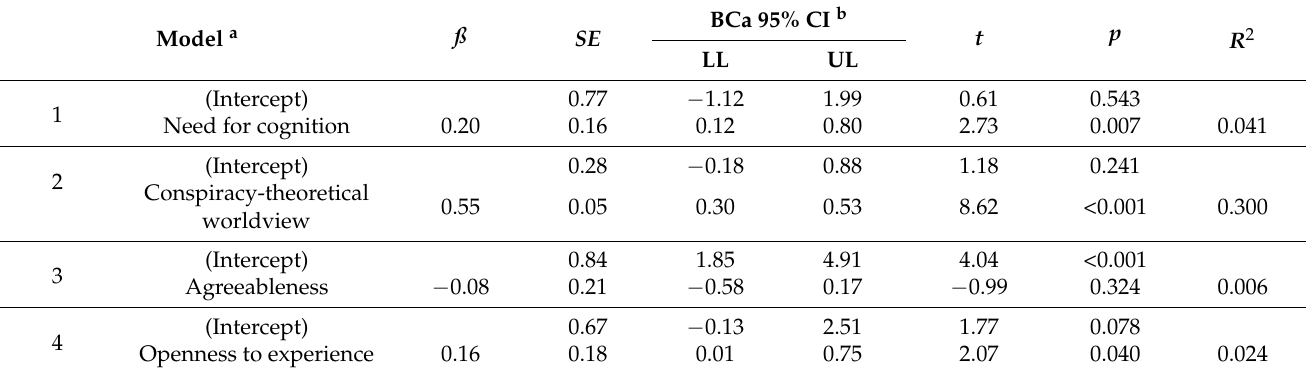
Table 3. Regression analysis: perceived credibility of the conspiracy-theoretical posting as